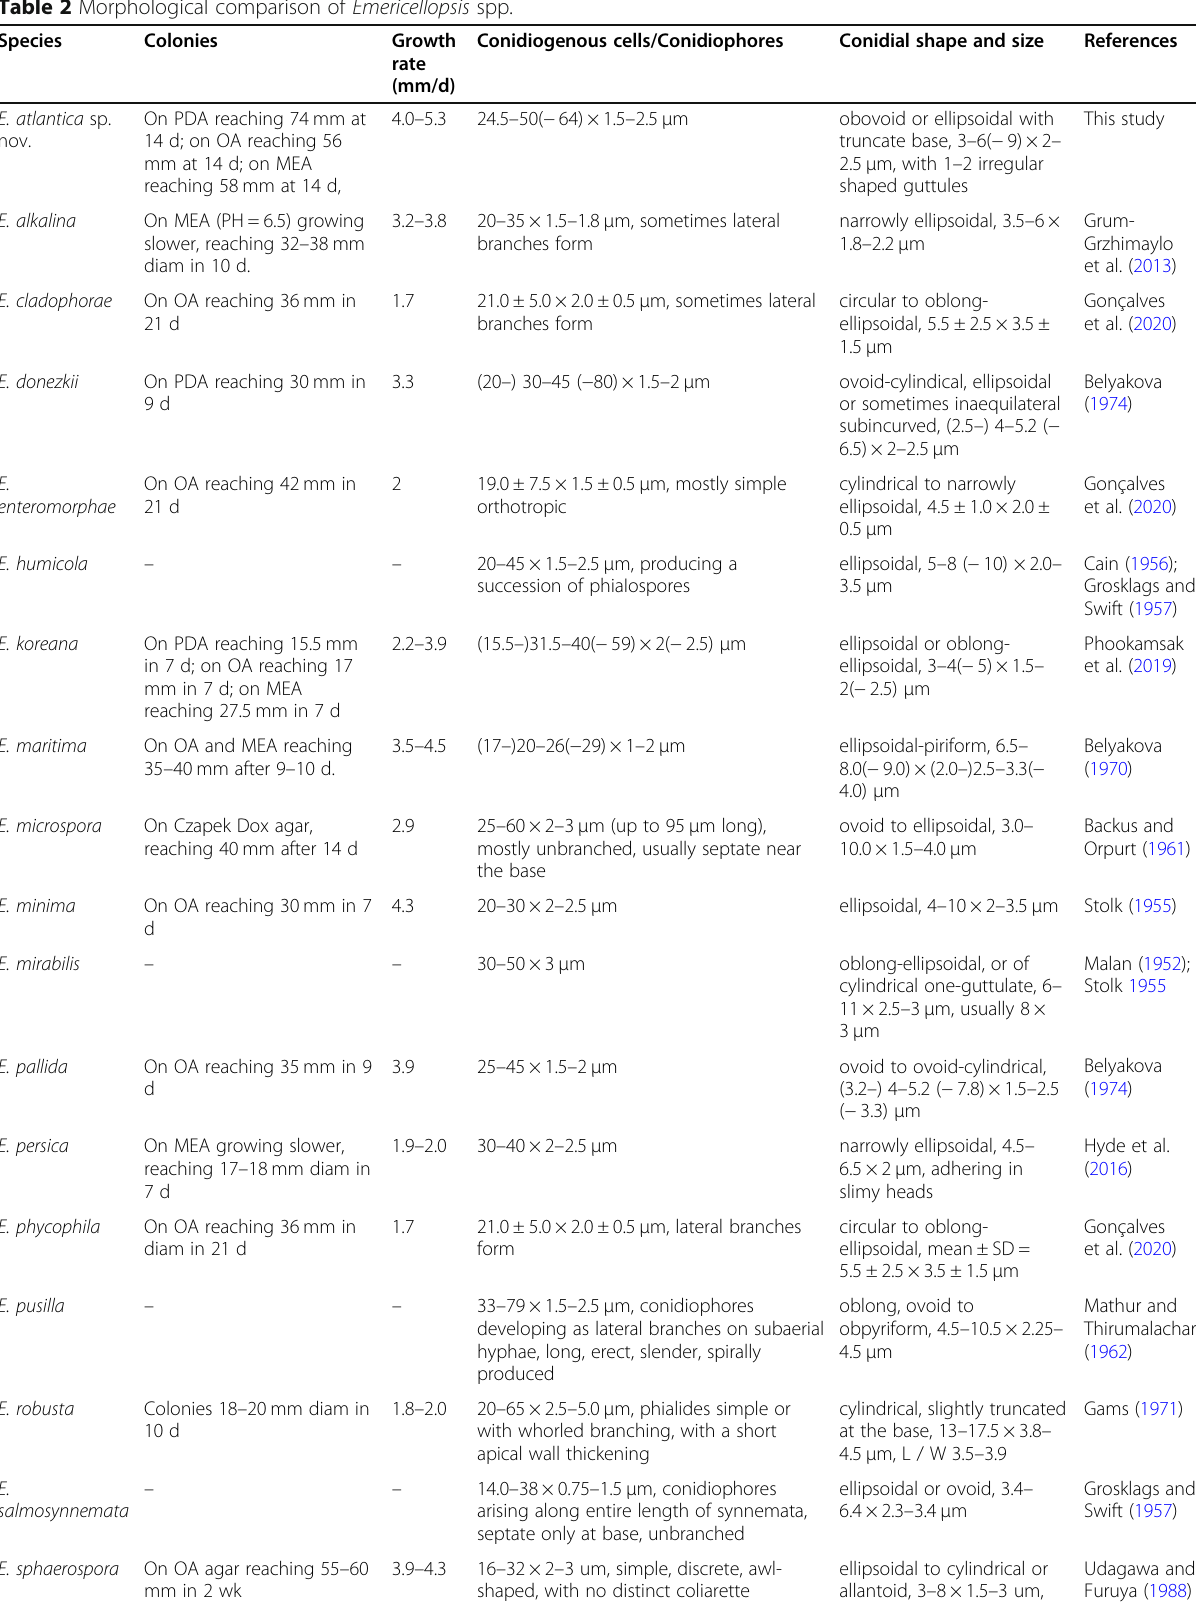
Table 2 Morphological comparison of Emericellopsis